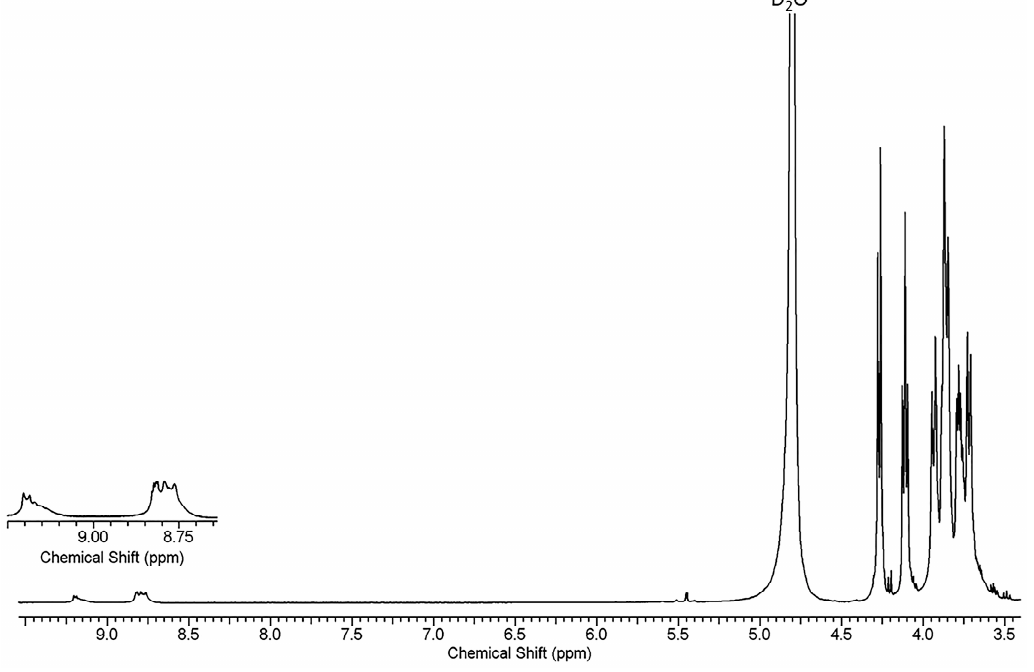
Figure 4. 1 H-NMR spectra of MPIEDPCA confirming PCA attachment to MPI.